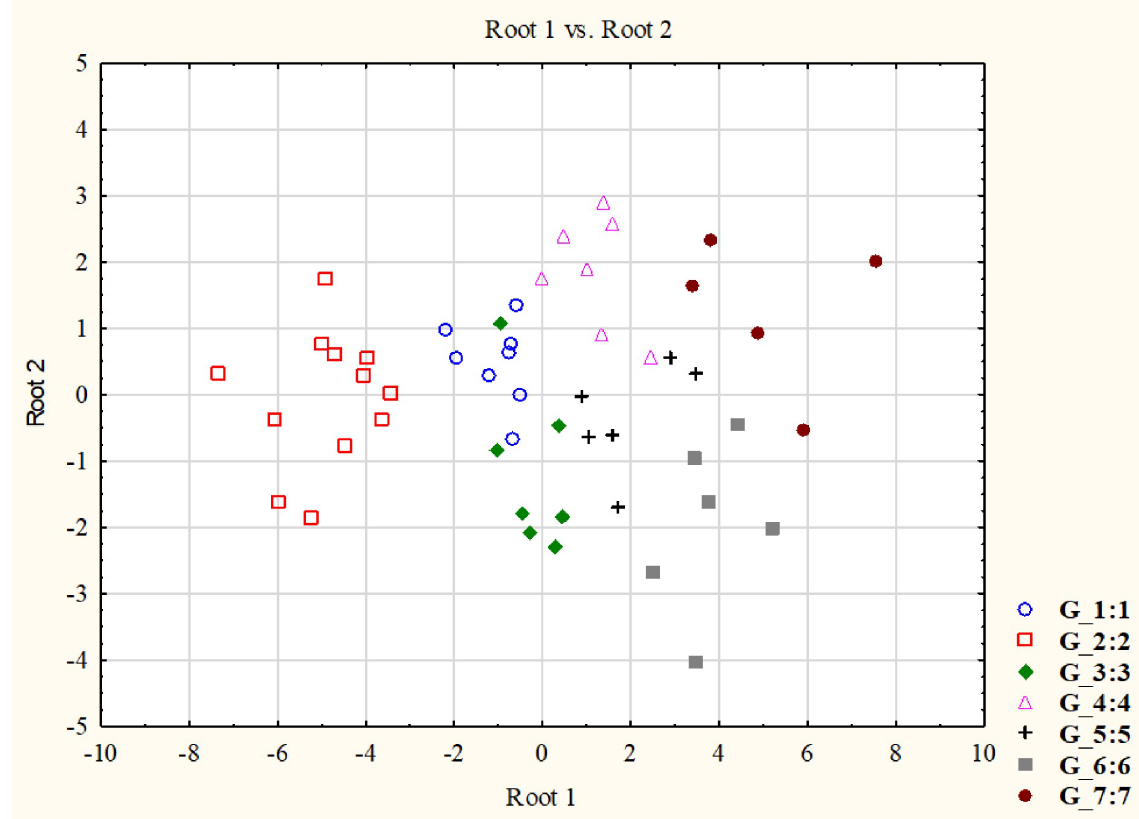
Fig 5. Discriminant analysis of the 7 phenotypic clusters of 51 wheat genotypes. The seven phenotypic clusters were established by K-means clustering of the grain yield data matrix, which was derived from the various heat stress treatment of Experiments I. and II.